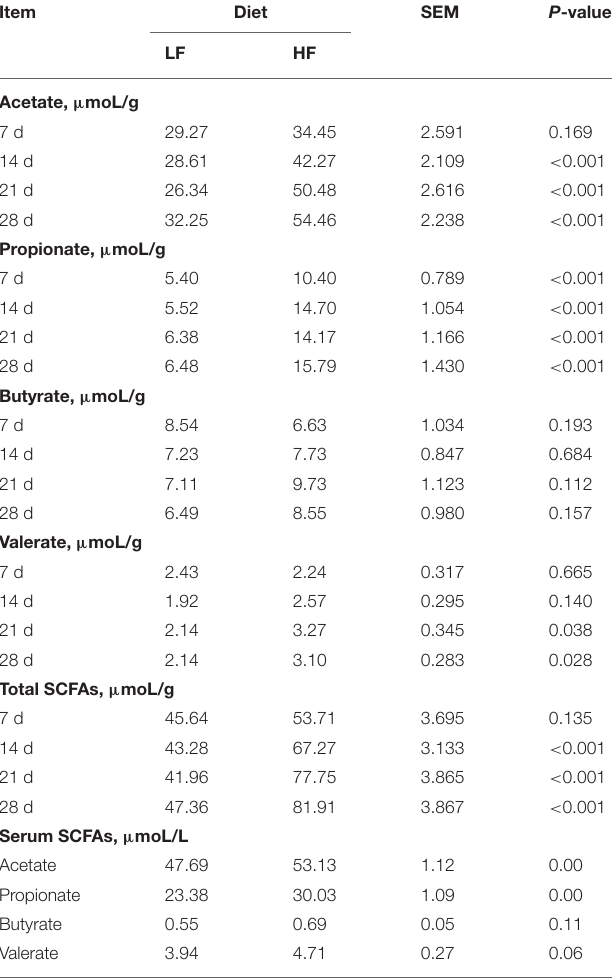
TABLE 3 | Effect of dietary fiber on the concentration of short-chain fatty acids in feces and serum of piglets a . Item Diet SEM